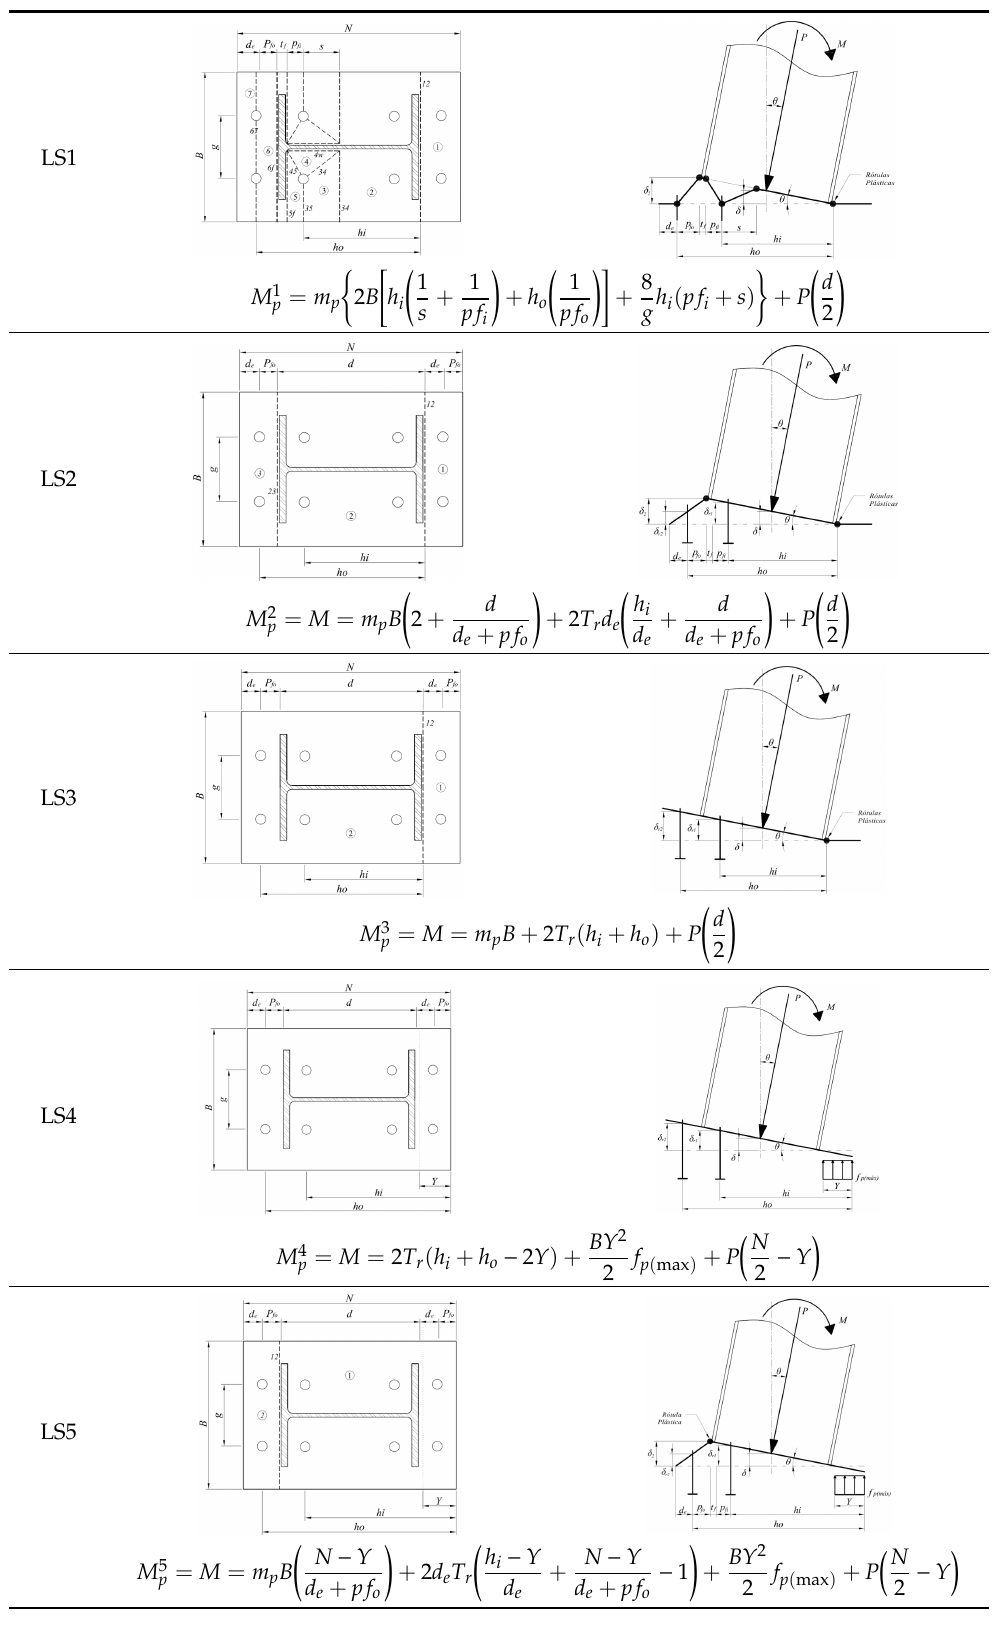
Table 3. Limit states that control the design of base plate type UBP-2.